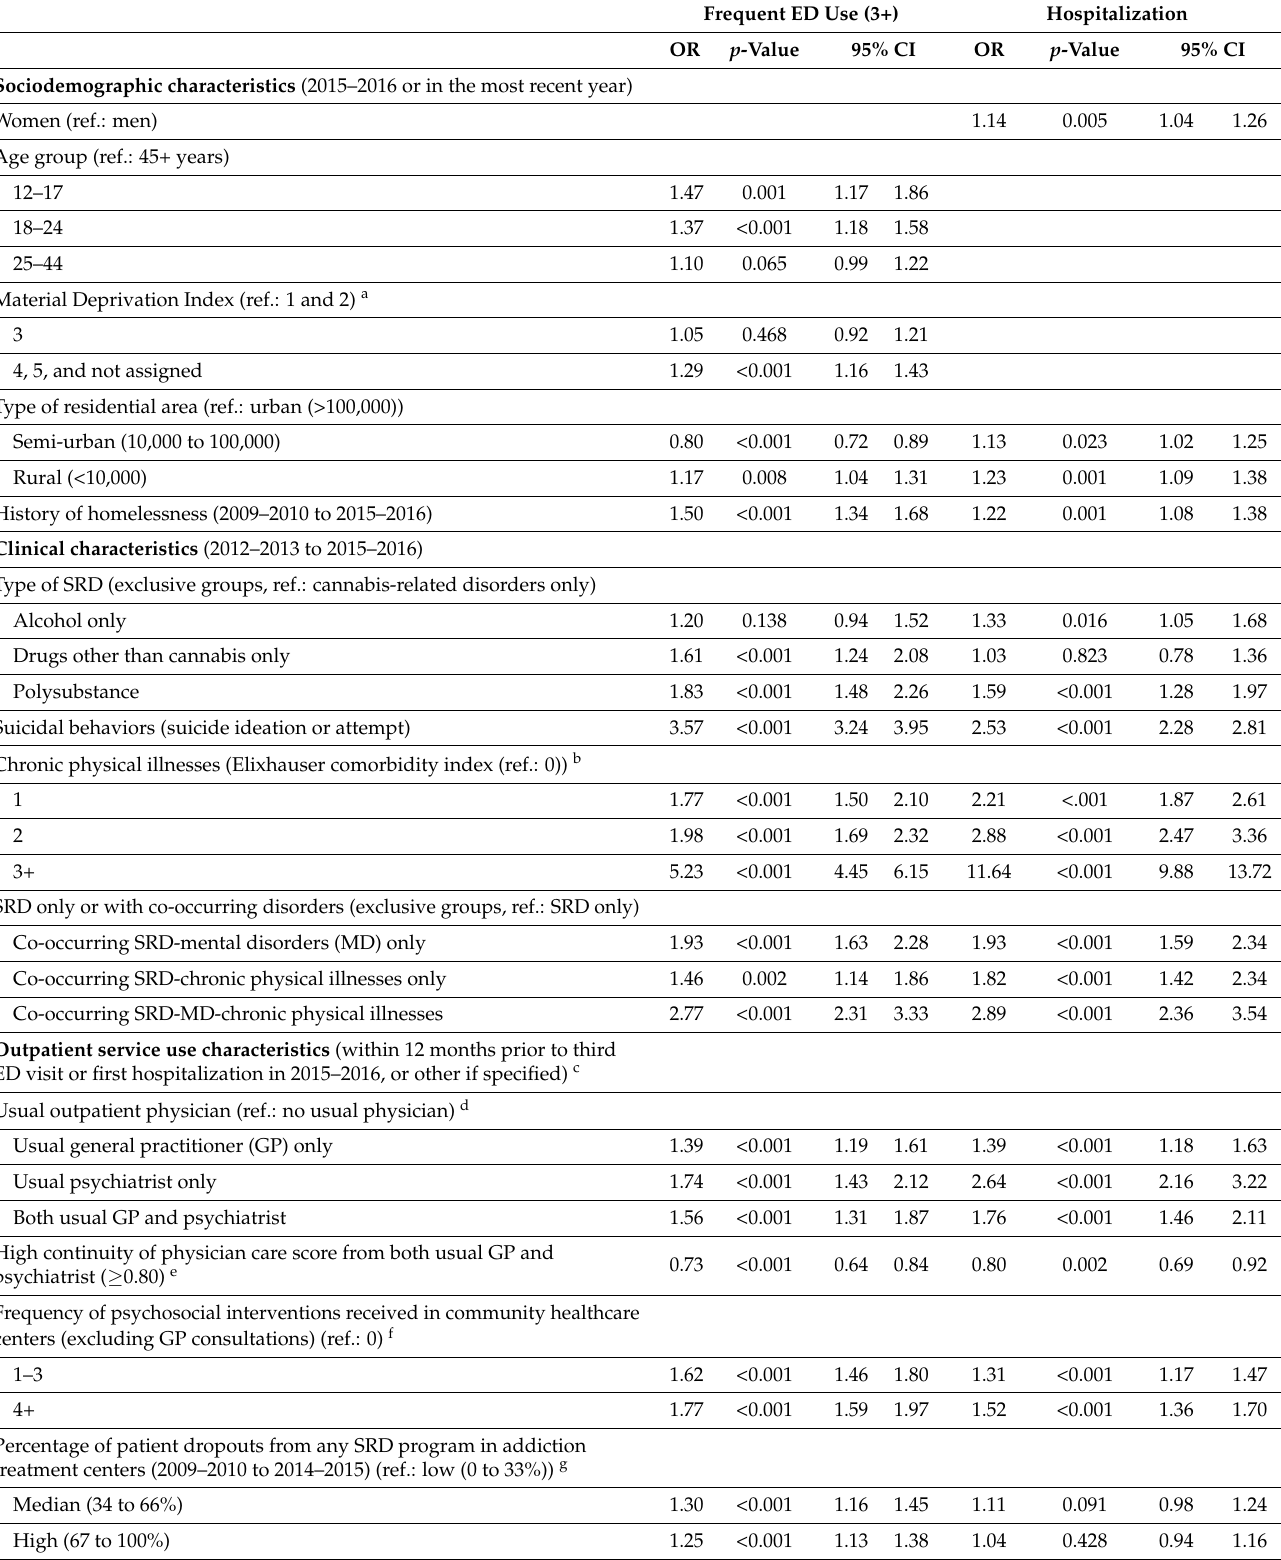
Table 2. Multivariable logistic regression results among patients with substance-related disorders (SRD) with frequent emergency department (ED) use, or hospitalization in